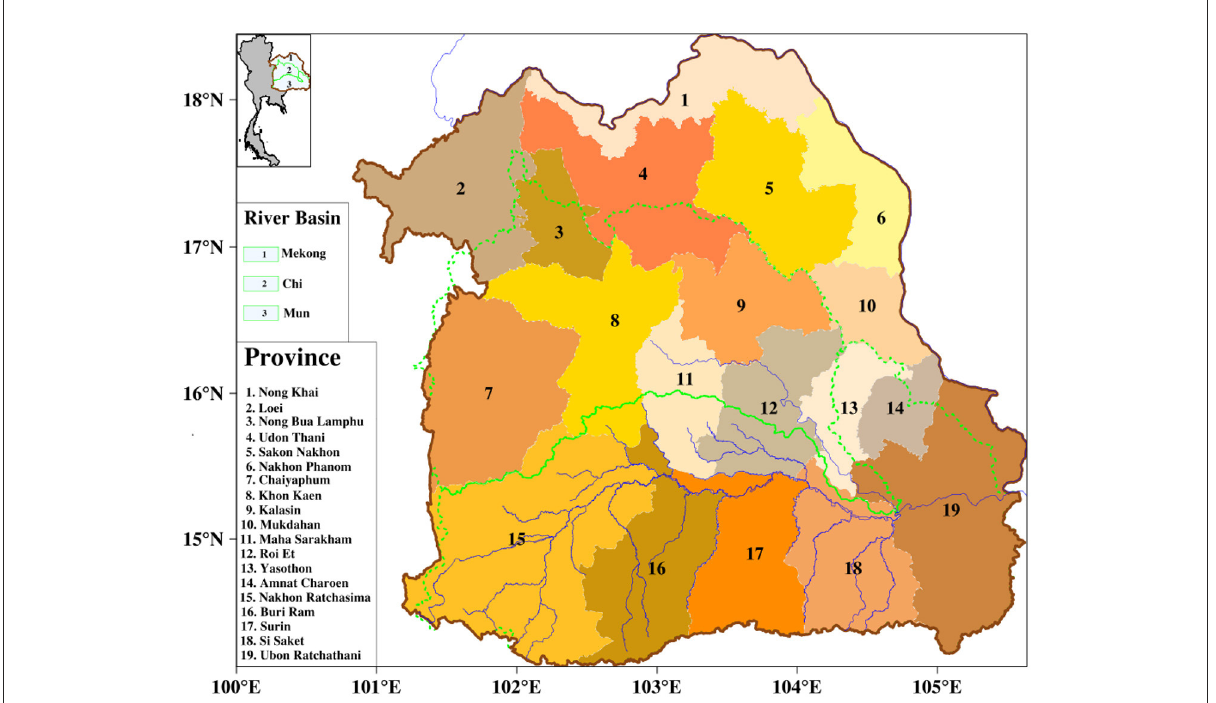
FIGURE1 Map of Northeast Thailand detailing the outline of the provinces, the river basin, and its location relative to Thailand on the inset map (top left corner).